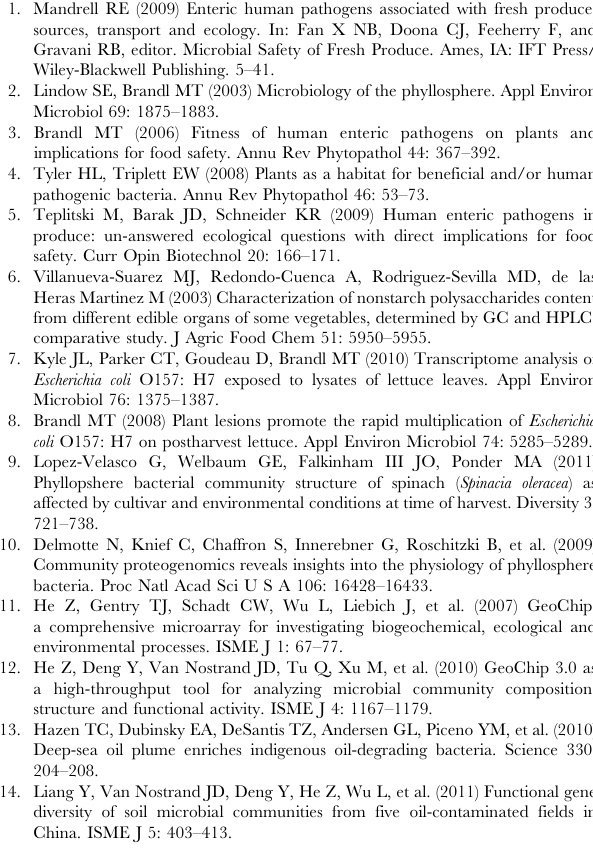
Table S4 All genes with significant difference in signal intensity between the control- and the EcO157-inoculat- ed biofilm community. Table S5 Phylogeny origins of carbon degrading genes in biofilm communities. Table S6 Phylogeny origins of genes involved in nitro- gen cycling in biofilm communities. Table S7 Phylogeny origins of genes involved in phos- phorus utilization in biofilm